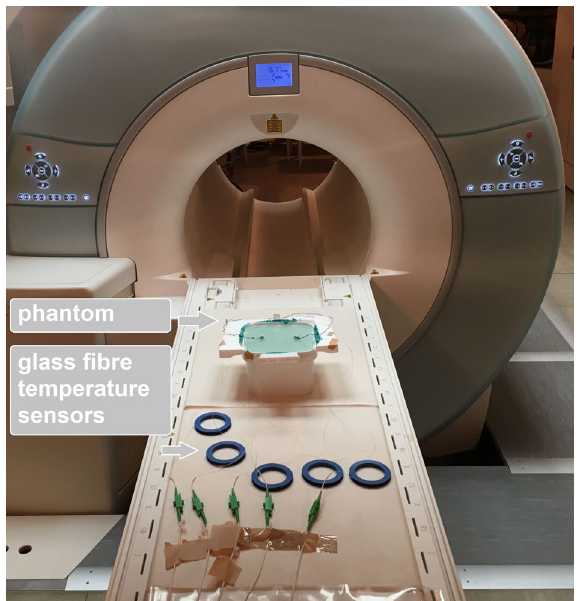
Figure 3. Setup with MRI. In the foreground, the temperature sensors are attached to the table, behind them is the head phantom with the electrodes and